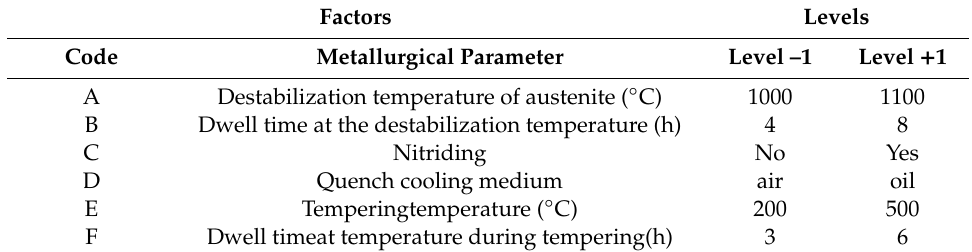
Table 2. Factors and levels analyzed in the design of experiments (DOE) (cooling medium after tempering: Air).